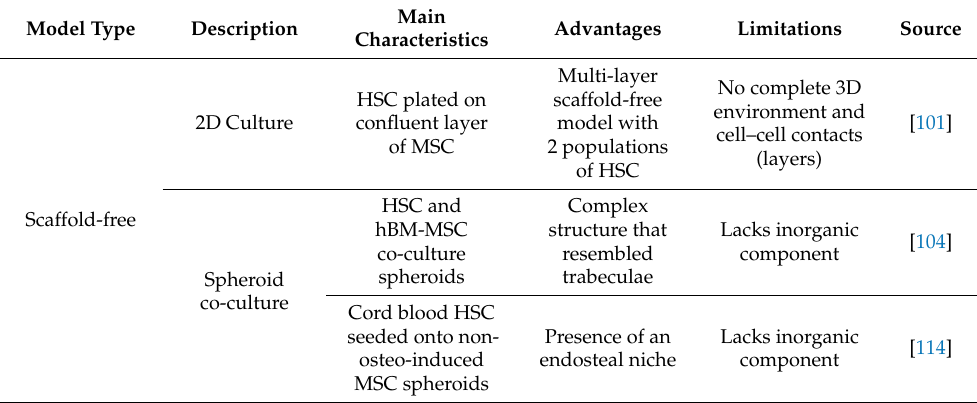
Table 1. Overview of in vitro bone marrow analogues grouped by their design